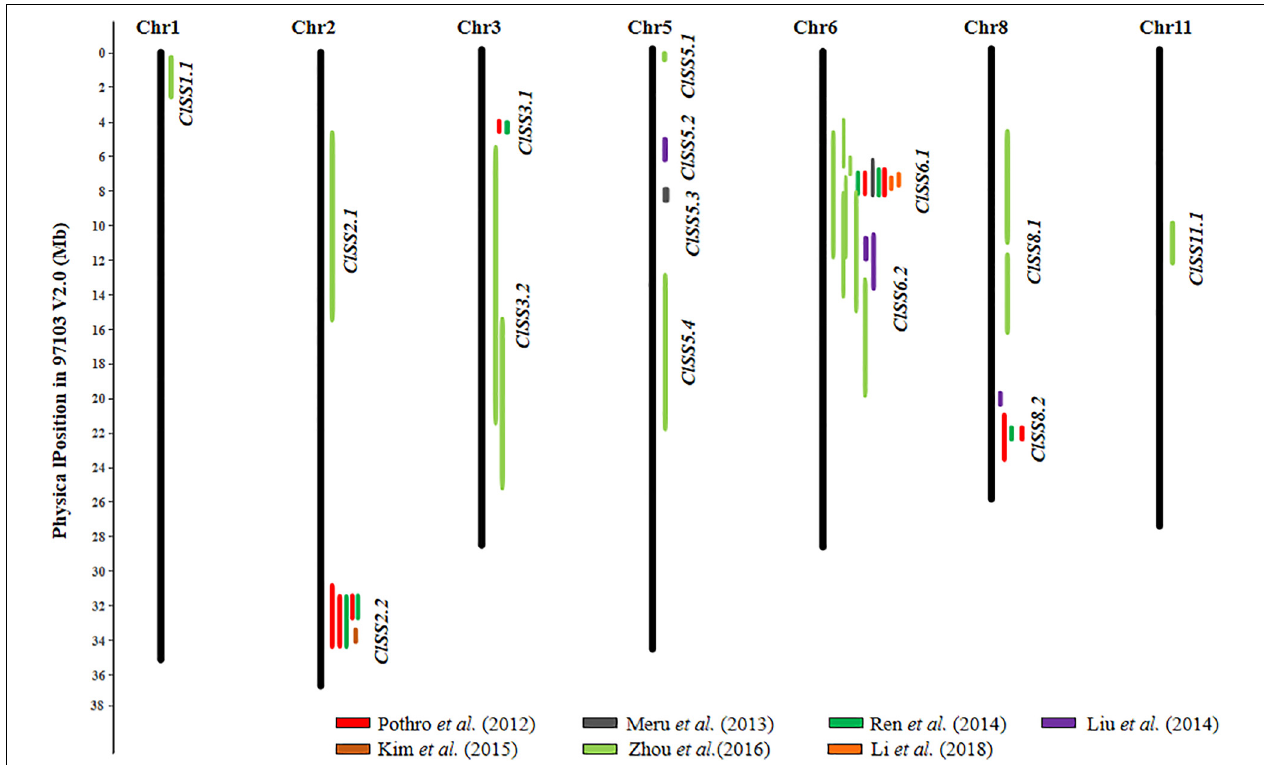
FIGURE 2 | Distribution of 14 seed size (SS) consensus QTL in the watermelon (97103 V2.0) draft genome. Physical LOD intervals of QTL identified from different studies are presented to the right of each chromosome. QTL detected by the same study are showed with same color. Only chromosomes harboring seed size QTL are